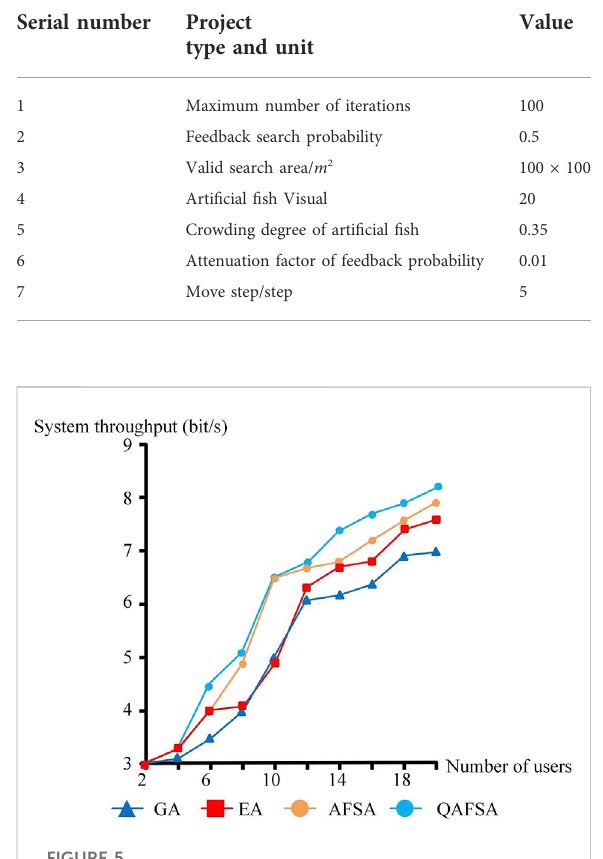
FIGURE 5 Throughput change curve of wireless network communication system.